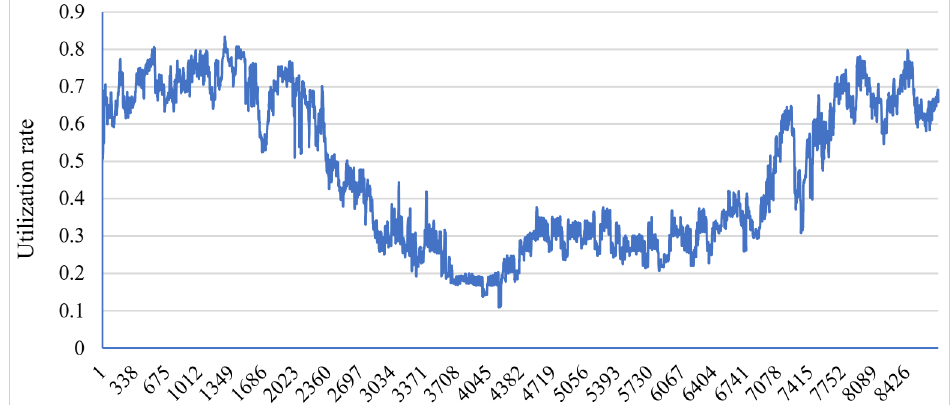
Figure 6. The average utilisation rate of CHP plants in 2018 (based on [33]).